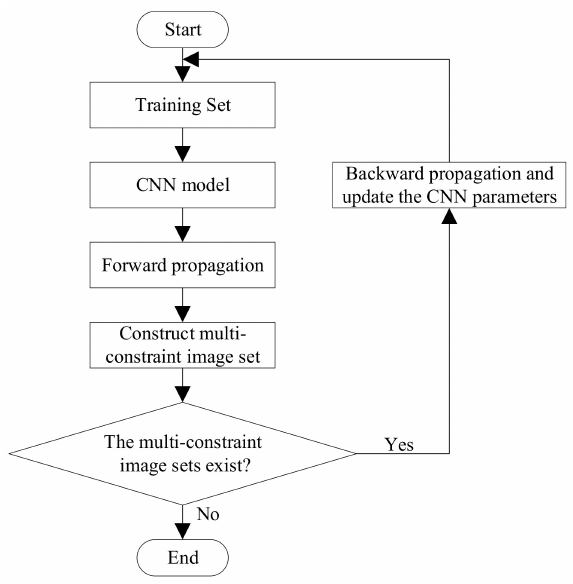
Figure 4. The diagram of the training